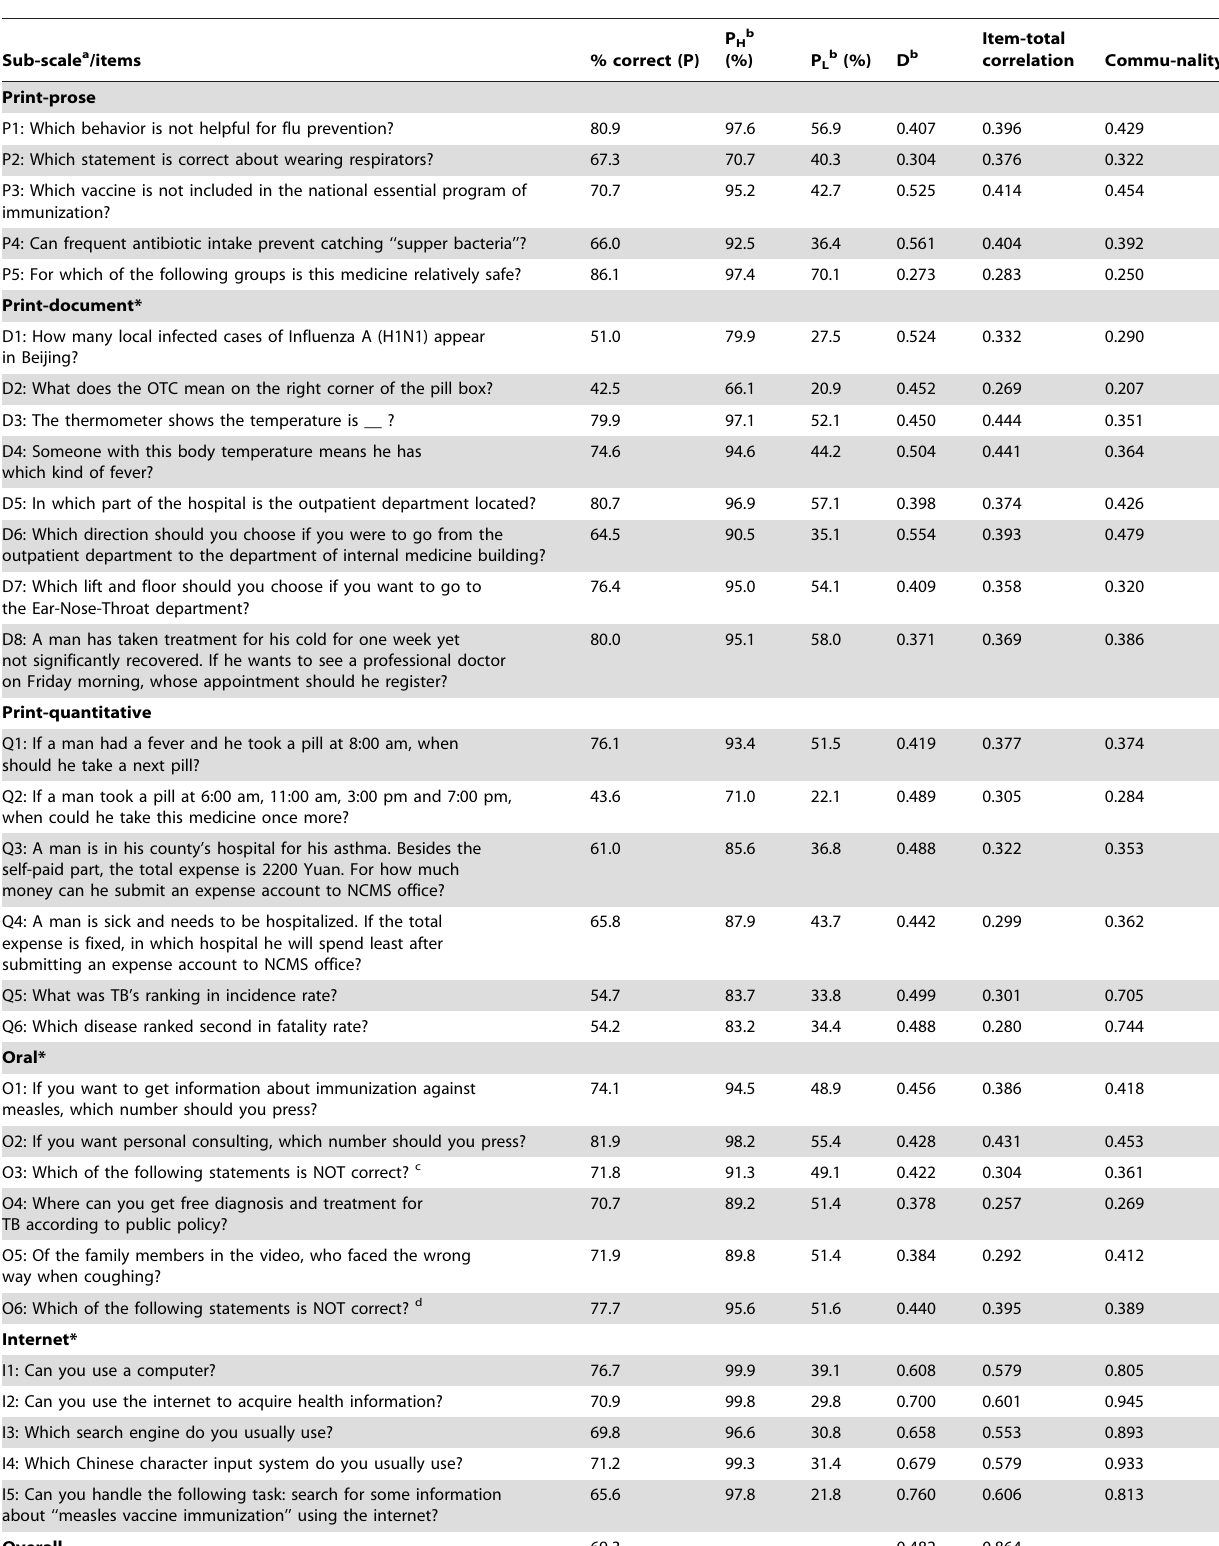
Table 2. Psychometric properties of health literacy items regarding infectious respiratory.